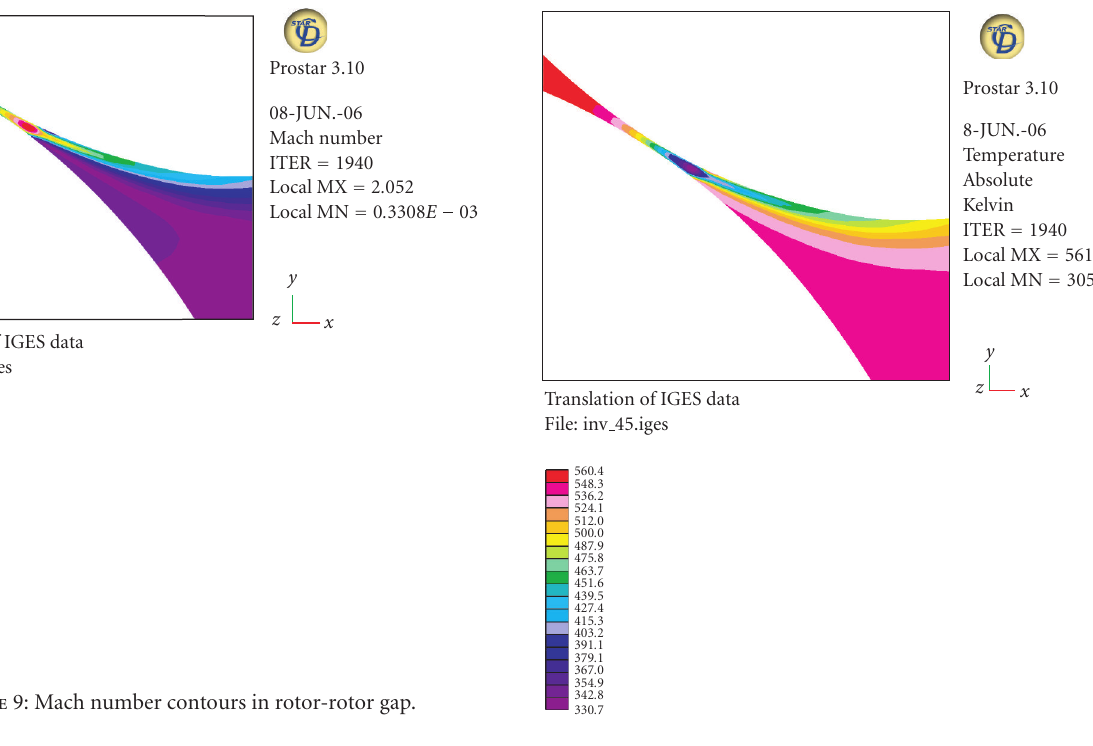
increase and equalizes with the reservoir pressure. Thus, a k − ω turbulence model is proper for simulating the e ff ects of this adverse pressure gradient. (In the case of an unchoked flow, the pressure also decreases until the throat and then in- creases, resulting in an unfavorable pressure gradient.)